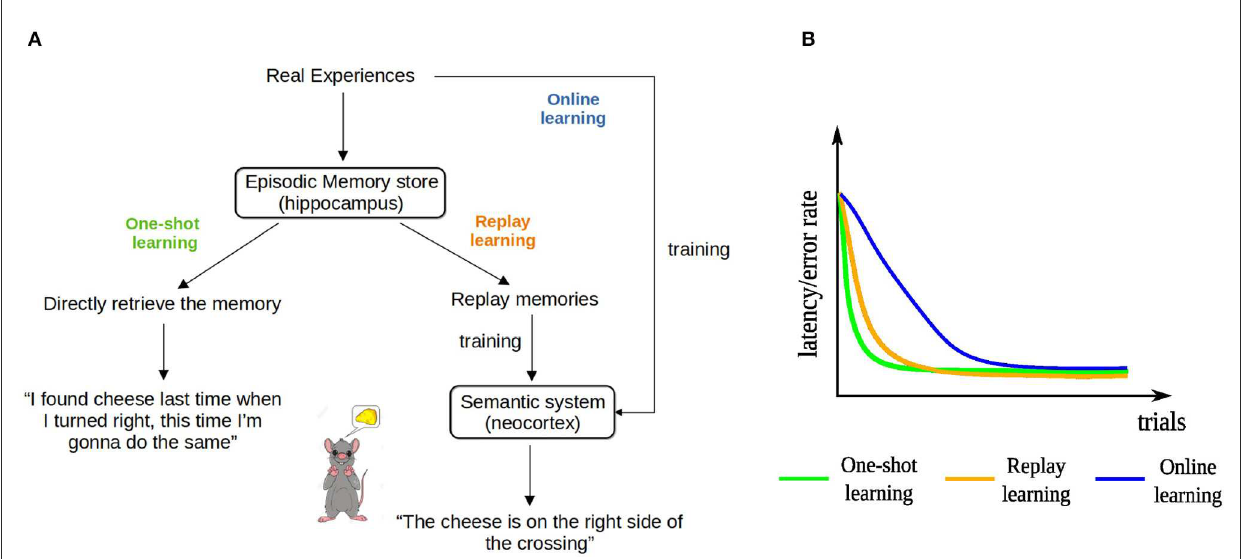
FIGURE1 The three hypothesized learning paradigms and their learning curves. (A) Schematic illustration of the three learning paradigms for the example of a rat running in a T-maze. (B) The hypothesized learning curves of the three learning paradigms for a spatial learning